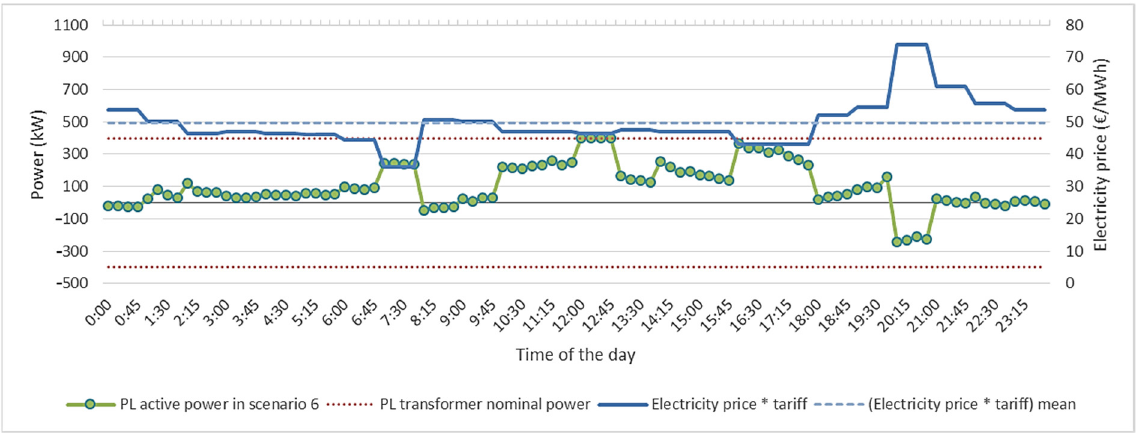
Figure 13. PL’s active power in scenario 6 and electricity price.